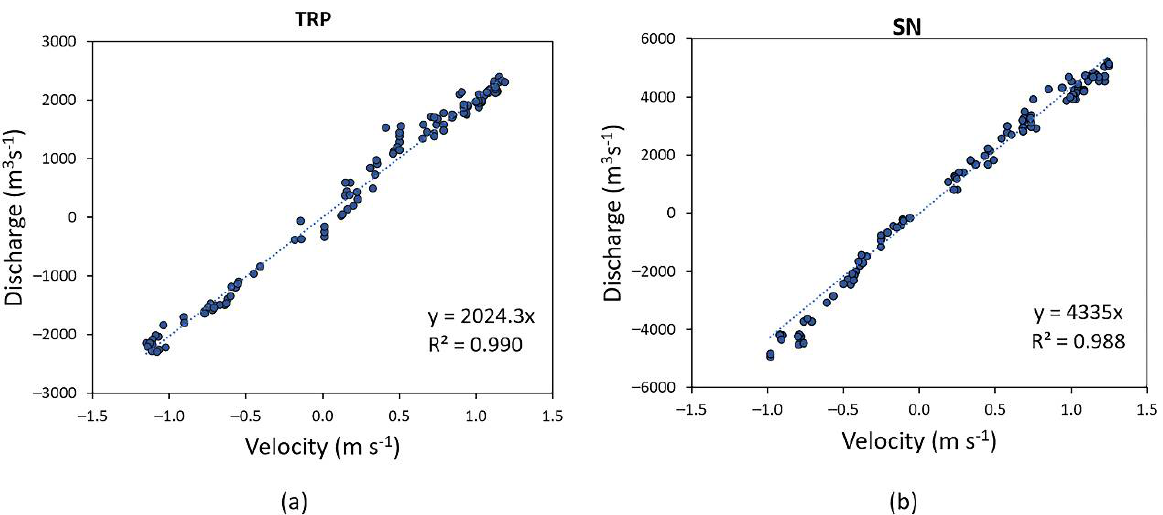
Figure 5. Linear regressions between the vertically averaged velocities by fixed ADCPs (the index- velocity) and instantaneous discharge data from the ADCP transects for the ( a ) Treporti (TRP) and ( b ) San Nicolò (SN) stations. Dotted lines are the best-fit regression.